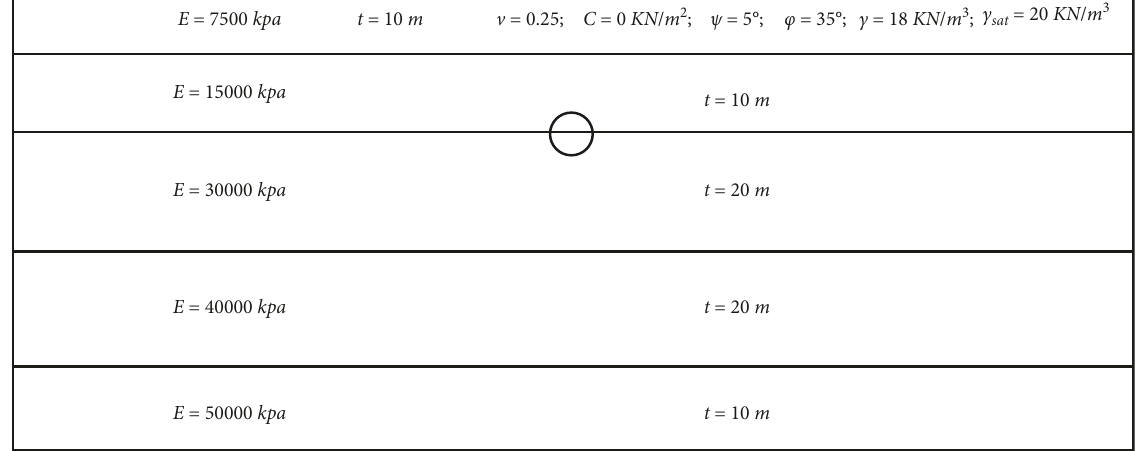
Figure 1: The properties of Delhi subway soil (main model) in different depths [25]. Table 1: Models considered in